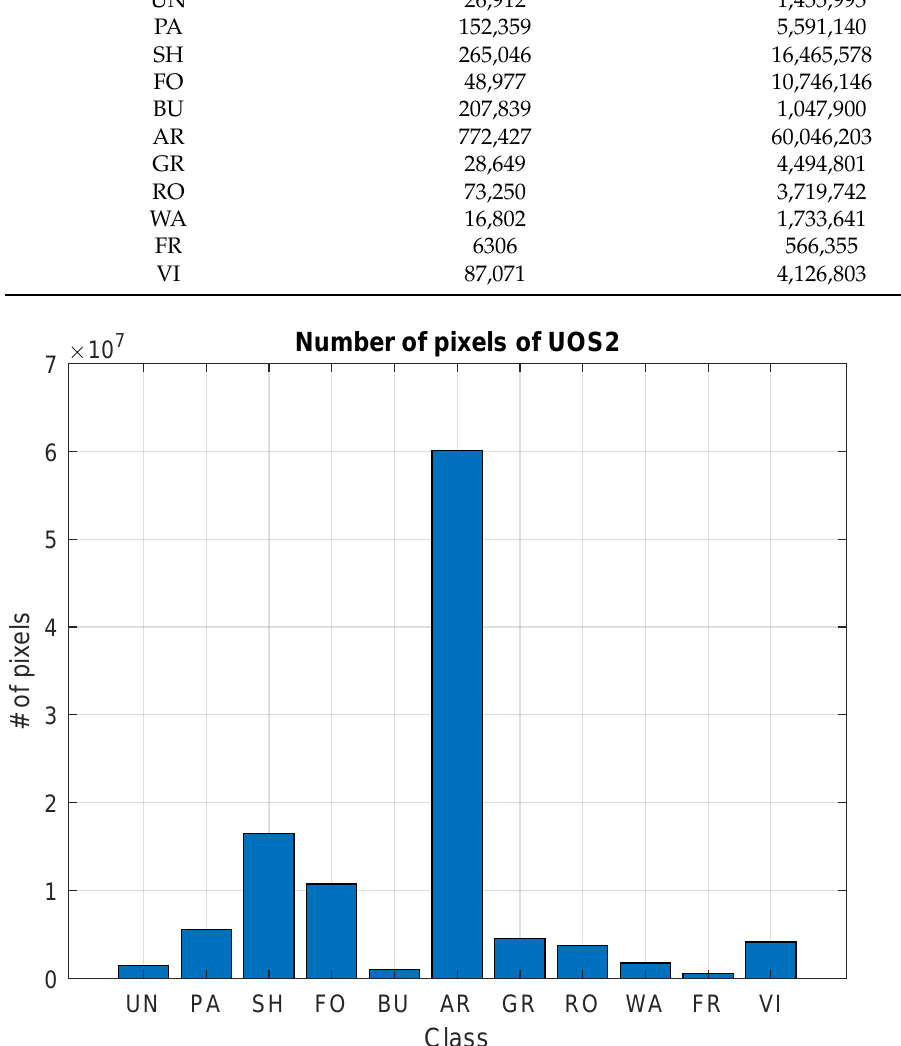
Figure 4. Number of pixels for each class of the dataset